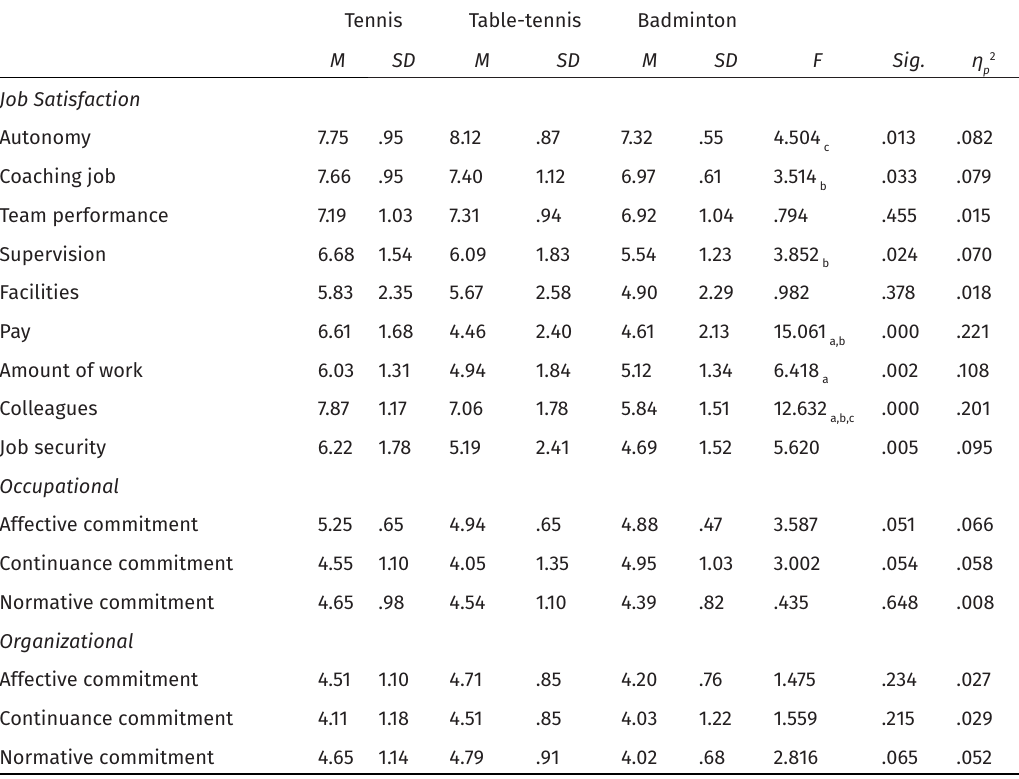
Table 1b. Mean differences in all variables between coaches of different racket sport Tennis Table-tennis Badminton